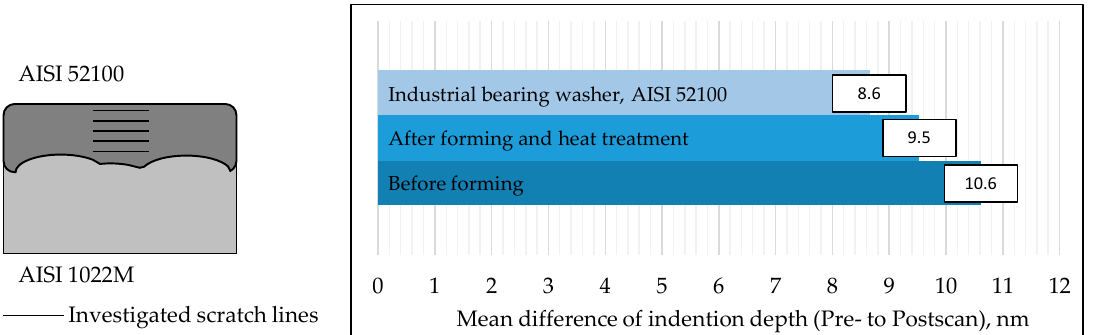
Figure 11. Evaluation of the scratch test of the cladding at different stages of the process chain.